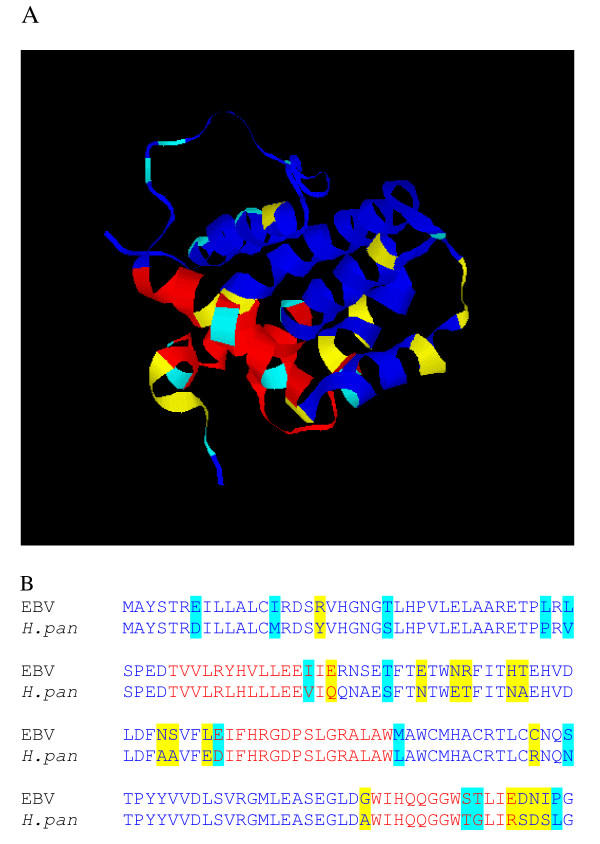
Mapping of amino acid changes in H. pan BHRF1 on the EBV BHRF1 structure. The structure of the first 160 amino acids of EBV BHRF1 was visualised by importing the structural data file (1q59.pdb) into RasMol v2.6, which converts the structural data into a 3 D image (Figure 6A) Using the RasMol edit commands we have highlighted the BH domains in red, whilst the remainder of the protein is shown in dark blue. Conservative replacements in the H. pan protein are highlighted in light blue and non-conservative replacements are shown in yellow. For comparison the aligned amino acid sequenced are shown in Figure 6B, using the same colour coding as in Figure 6A.